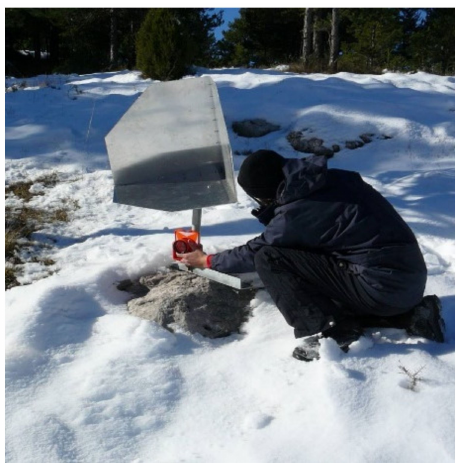
Figure 19. One of the small Corner Reflectors deployed over the landslide lower unit in order to fix up the vegetation and snow problems. The operator is holding a surveying circular prism, which is observed from a reference point with a Total Station, for validation